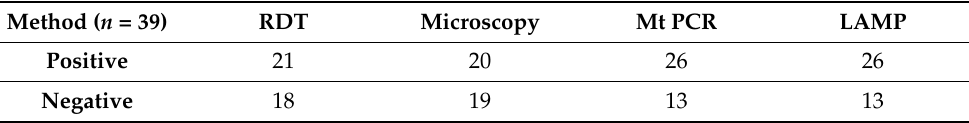
Table 2. Summary of performance of microscopy, rapid diagnostic test (RDT), mitochondrial poly- merase chain reaction (PCR), and LAMP methods in clinical samples. Method ( n = 39) RDT Microscopy Mt PCR